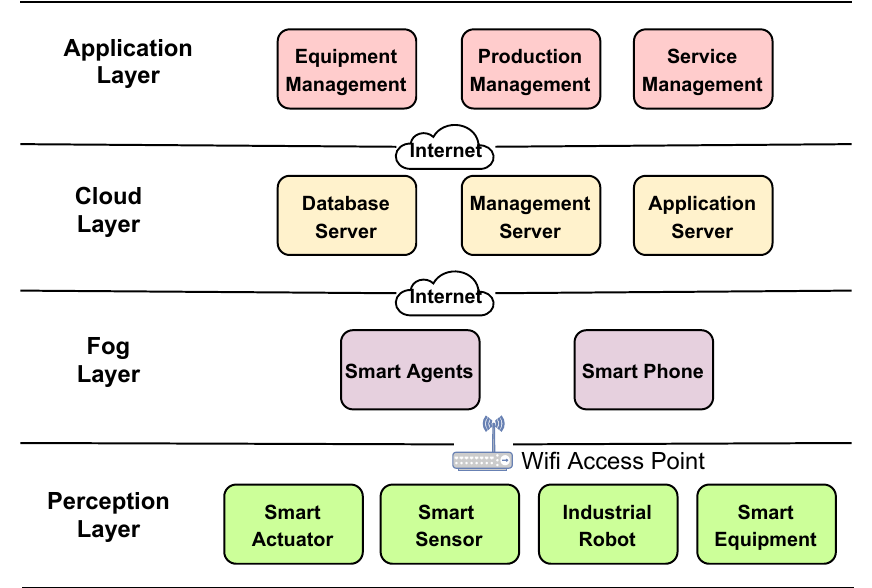
Figure 9. Outline of a four-layer IIoT architecture